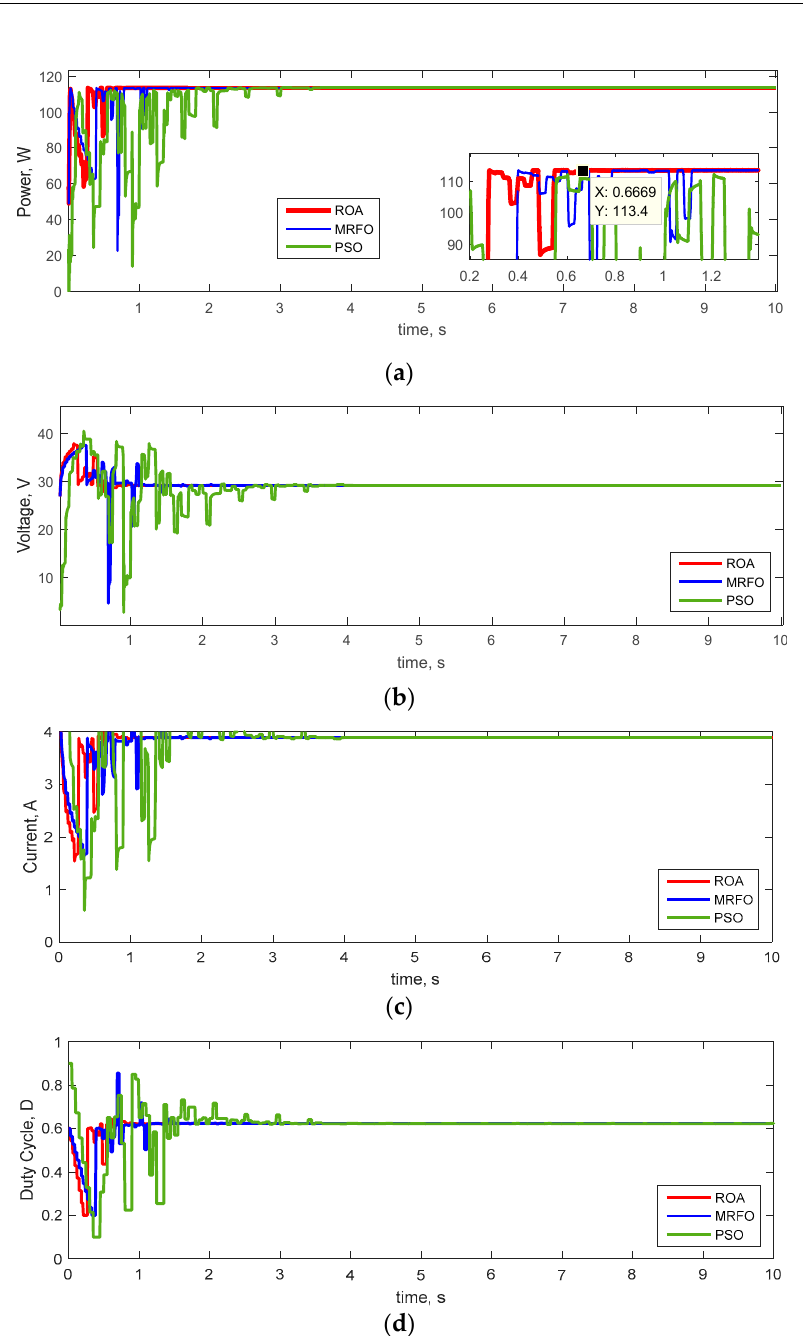
Figure 9. ( a ) PV power, ( b ) PV voltage, ( c ) PV current, ( d ) Duty cycle in pattern 1 using different